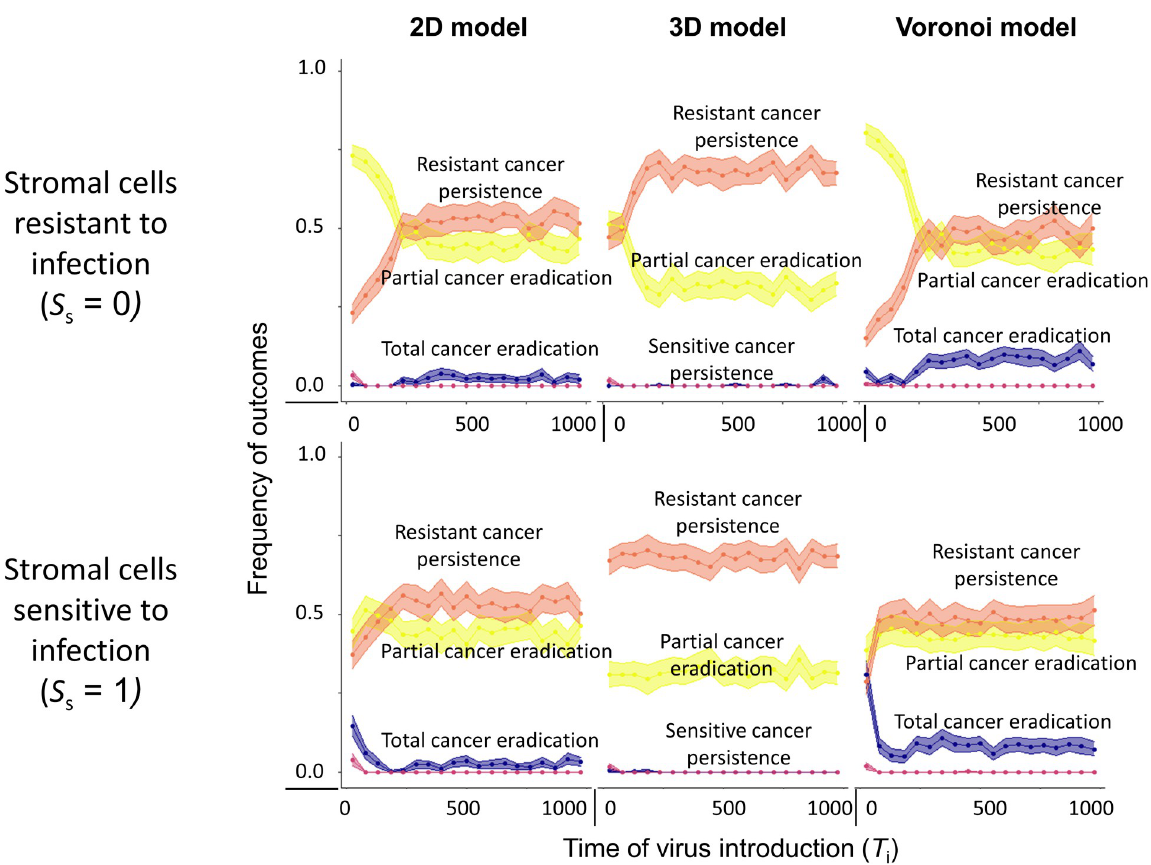
Fig 5. Effect of time of treatment on therapeutic outcome. Effect of the start of virotherapy ( T i ) on the therapeutic outcome in the Voronoi, 2D regular and 3D regular model. The top row describes the situation ( S s = 0) when stromal cells are resistant to viral infection, whereas the bottom row describes the scenario ( S s = 1) when stromal cells are sensitive to viral infection. Each panel represents 10,000 simulations per spatial configuration: for 1000 virus introduction times T i 10 replicate simulations were run, keeping all other model parameters at their default values (see Table 1). Due to stochasticity, the replicates for a given introduction time could differ in therapeutic outcome at time 1000. Coloured lines indicate the mean value, coloured envelopes indicate the 95% confidence band. Mean and confidence intervals in (A) were obtained via nonparametric